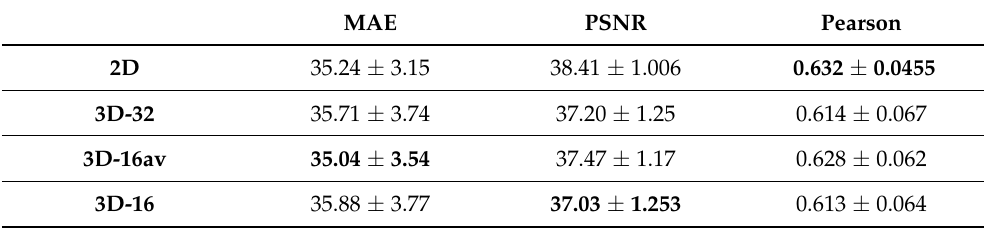
Table 25. Pelvis dataset Soft-tissue with U-net. Mean Absolute Error, PSNR and Pearson coeffi- cient from U-net using different convolutions and reconstructions in the Pelvis data set within the soft tissue.